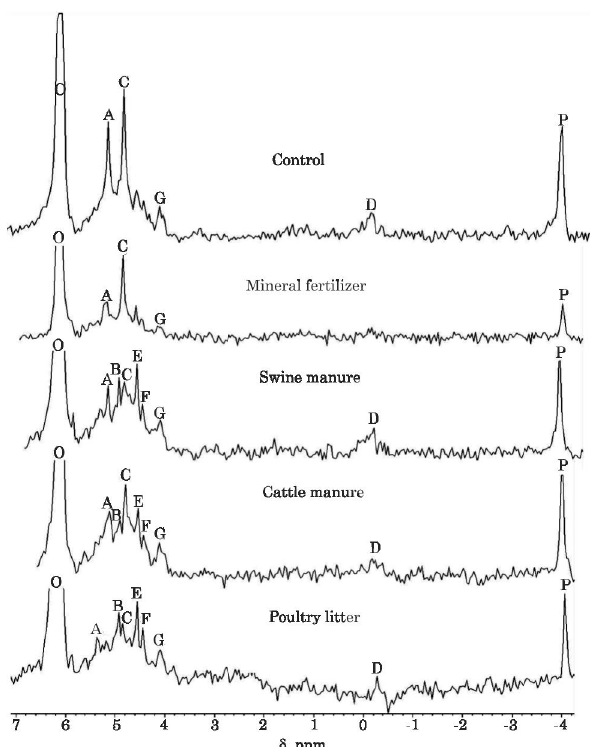
Figure 1. Solution 31 P-NMR spectra of NaOH - EDTA extracts of soil cultivated for nine years without fertilization and fertilized with cattle manure, swine manure, poultry litter and mineral fertilizer. Resonances O, P and A through G correspond to the peaks identified in table 2.